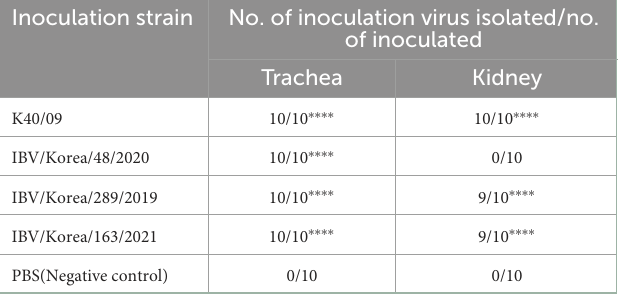
TABLE 2 Virus re-isolation rate in the trachea and